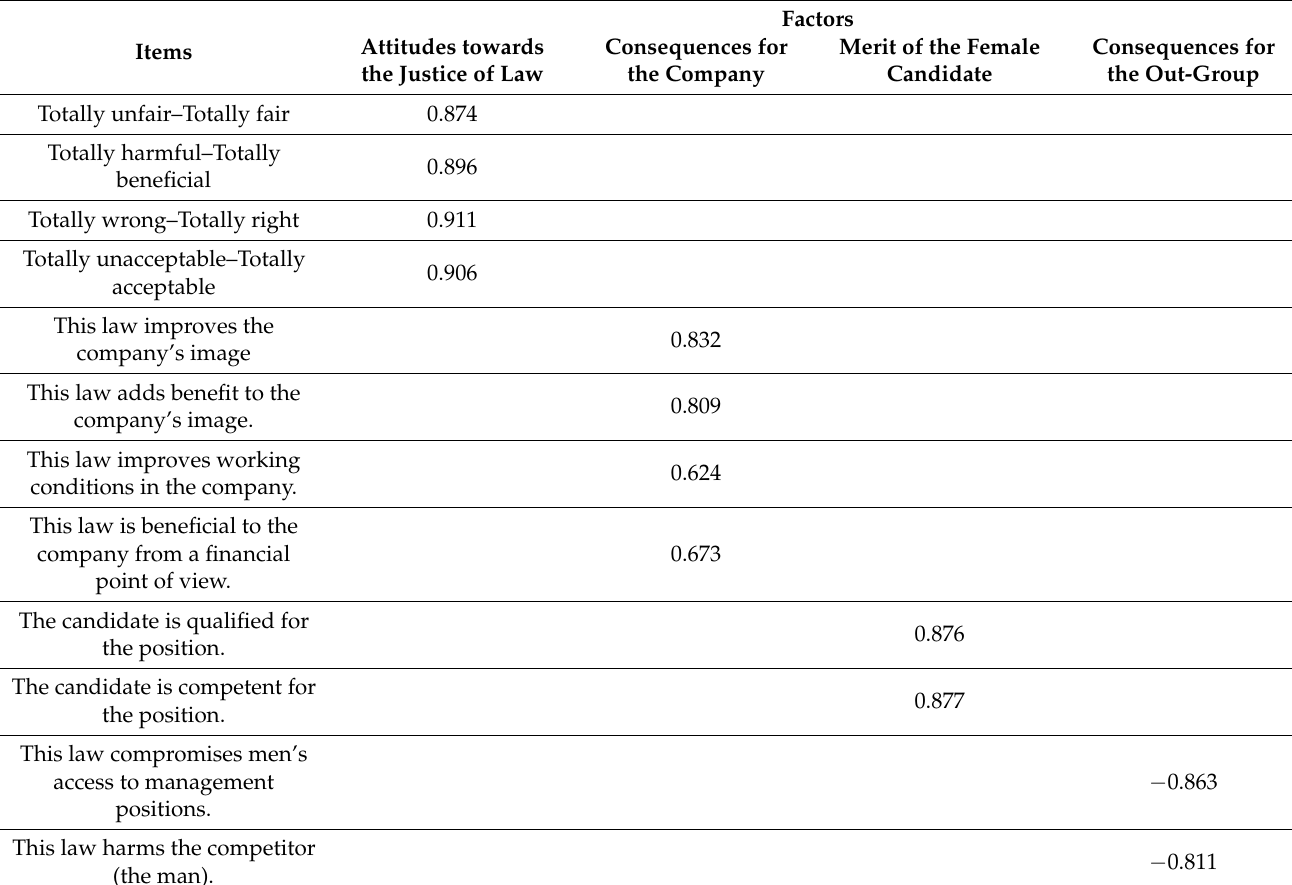
Table 1. Factor Analysis by Principal